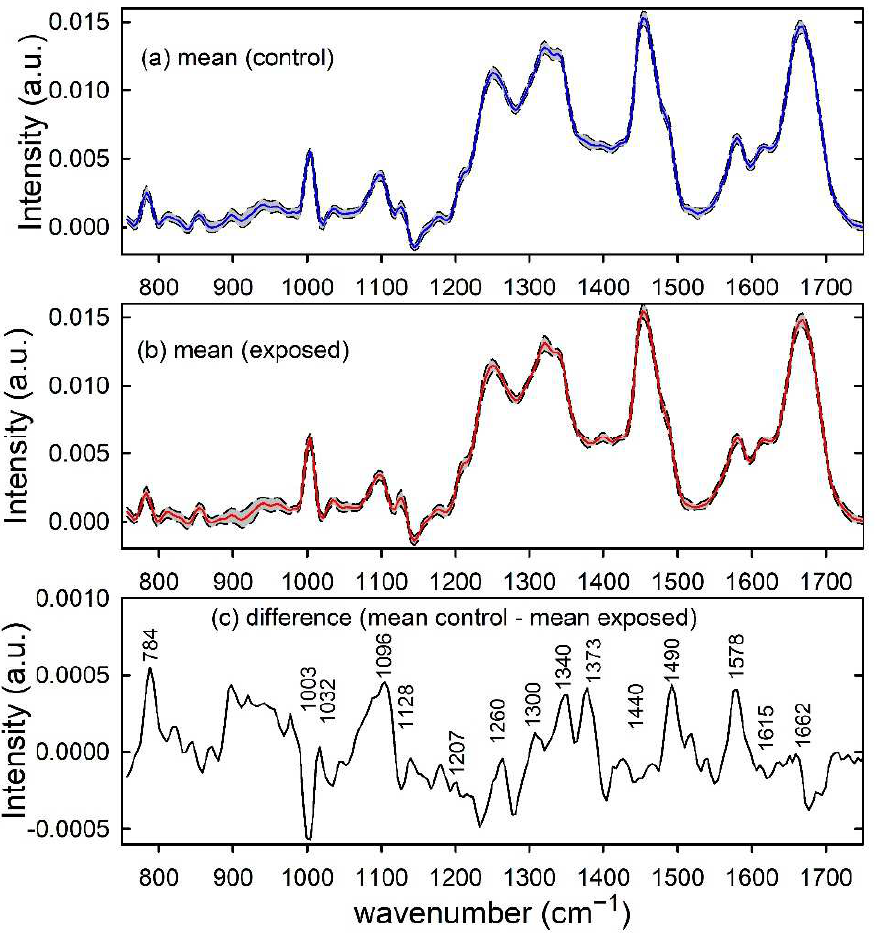
Figure 2. Raman spectra of control ( a ) and proton-exposed ( b ) MCF10A cells. The mean spectra are reported by blue and red lines in ( a , b ), respectively. Standard deviation spectra are also reported as dashed lines and the grey area corresponds to spectral values between mean ± standard deviation values. The spectral differences between mean values are reported in ( c ) and the wavenumber values of spectral features mainly contributing to such a difference are labelled for clarity.